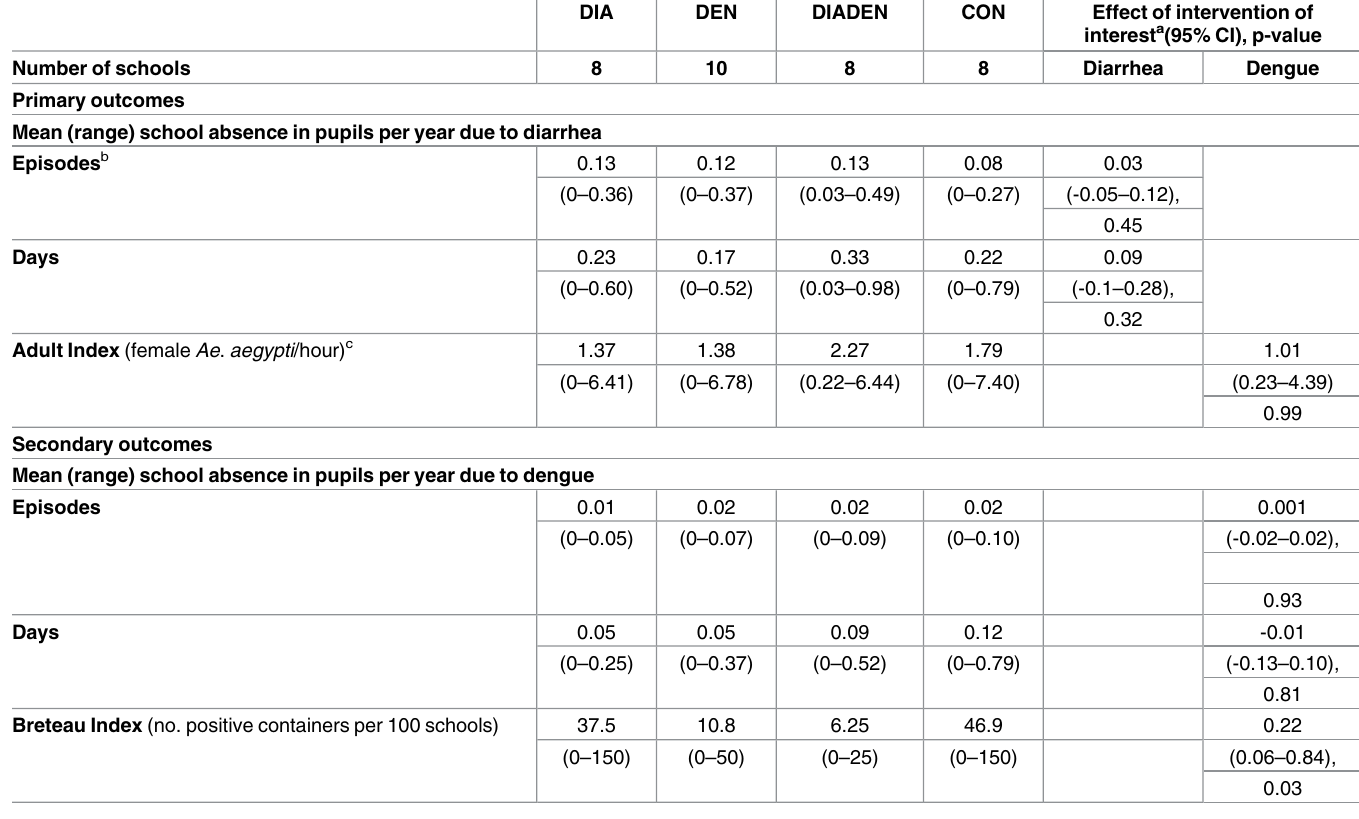
Table 3. Effect on primary and secondary outcomes of respective intervention in rural primary schools in arms receiving either diarrhea (DIA), dengue (DEN), both (DIADEN), or no intervention (CON) in Anapoima and La Mesa municipalities, Colombia, 2012–2013. DIA DEN DIADEN CON Effect of intervention of interest a (95% CI),